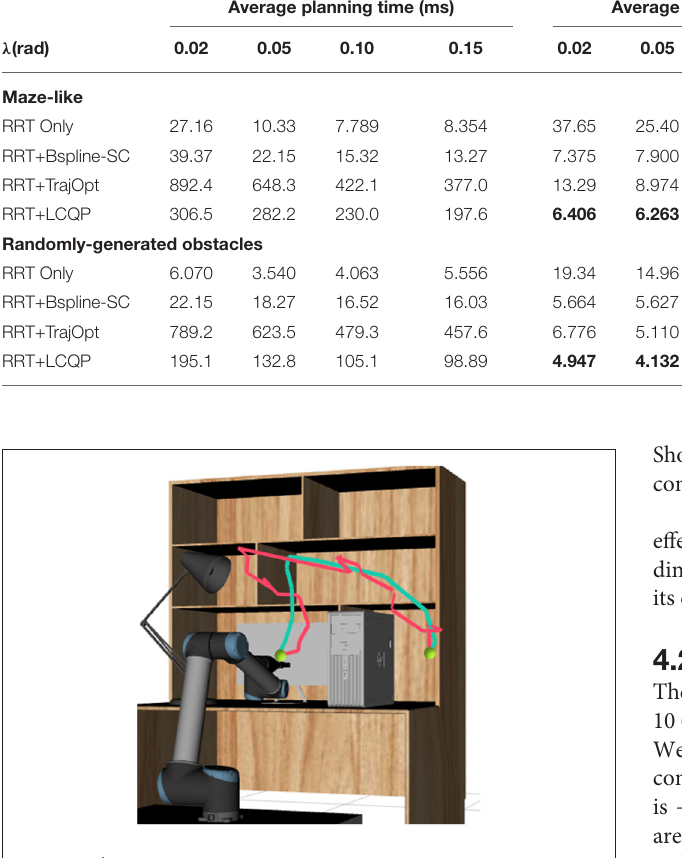
disparity that are inconvenient to indicate in the box plots, we display them in Table 2 . Each item is obtained by 50 repeated